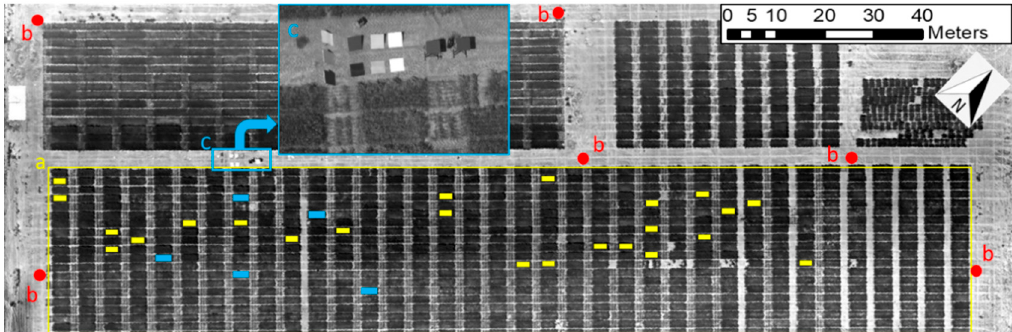
Figure 5. Experiment field at Texas A&M AgriLife research farm. ( a ) Delineations of the wheat field. ( b ) Ground control points. ( c ) Details of the test equipment on the ground, including temperature-controlled references and validation panels.